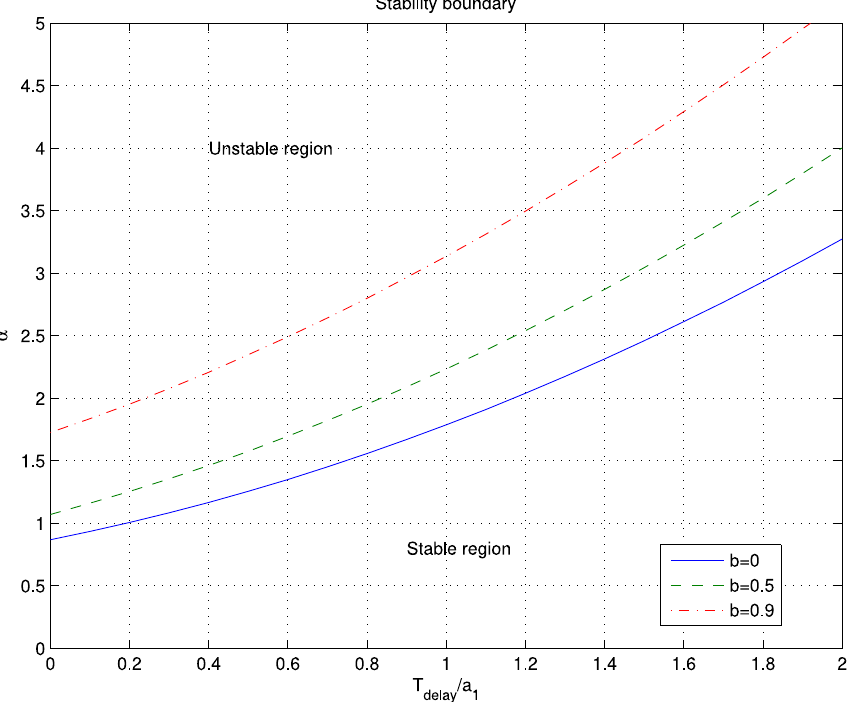
ff erent values of controller parameter b